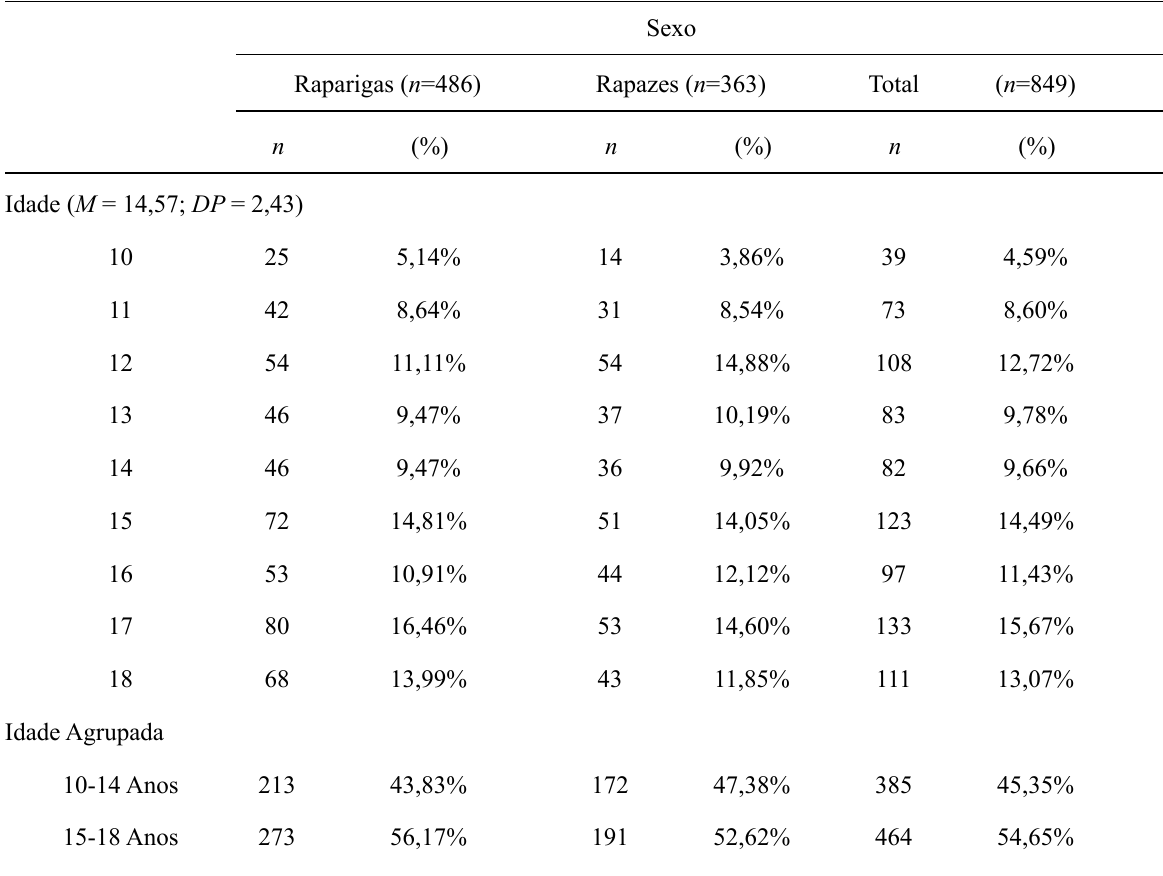
tabelecidos na minha casa…”), as quais correspondem às situações conformes às regras